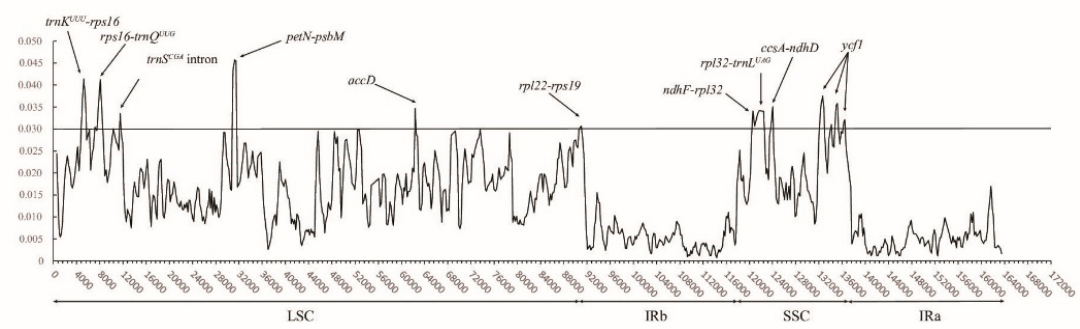
Figure 4. Nucleotide diversity ( Pi ) values across all Myrsinaceae s.str. cp genomes detected by sliding windows. X -axis, nucleotide positions in the cp genomes; Y -axis, nucleotide diversity ( Pi ) values. LSC: large single copy region; SSC: small single copy region; IR: inverted repeat region.